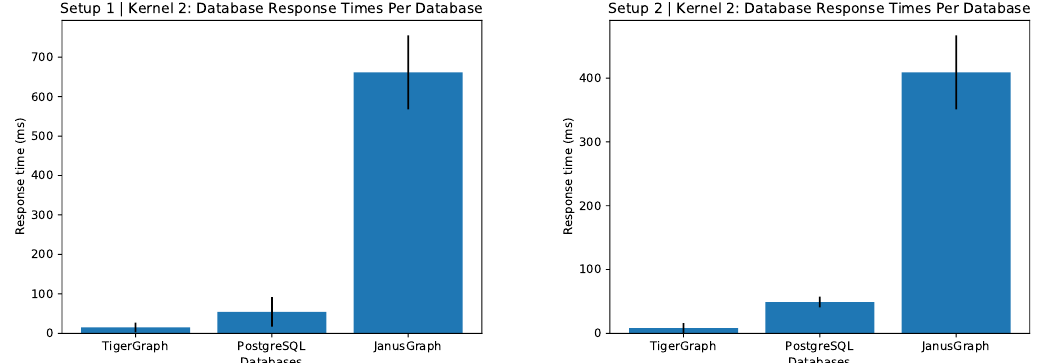
Figure 3. Database response times using the medical response dataset for setup 1 and 2 for the kernel: “Second Resource to Transfer Patients”. The error bars display standard deviation.